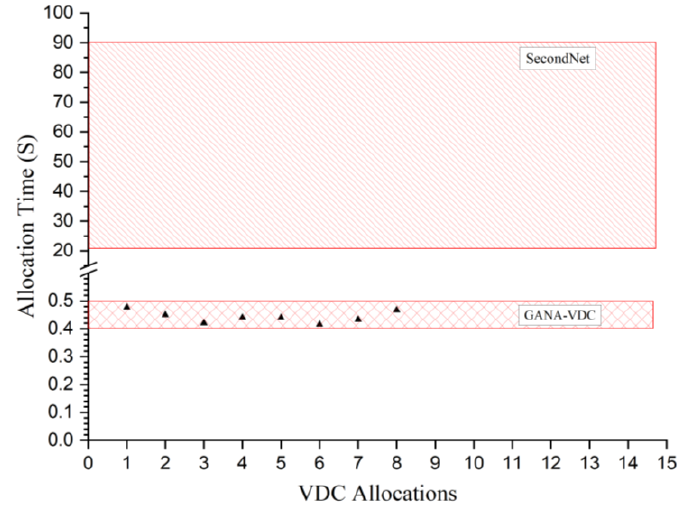
Figure 12. Comparison to SecondNet [13].